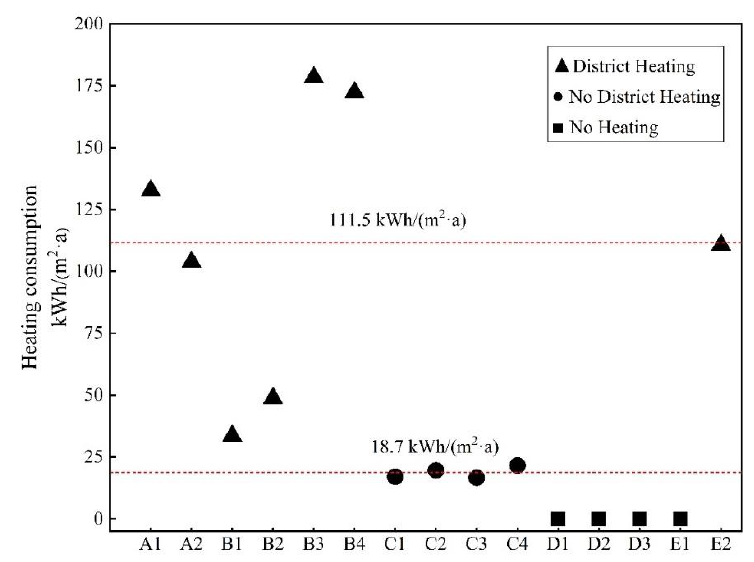
Figure 5. EUI of heating of high-speed railway stations.